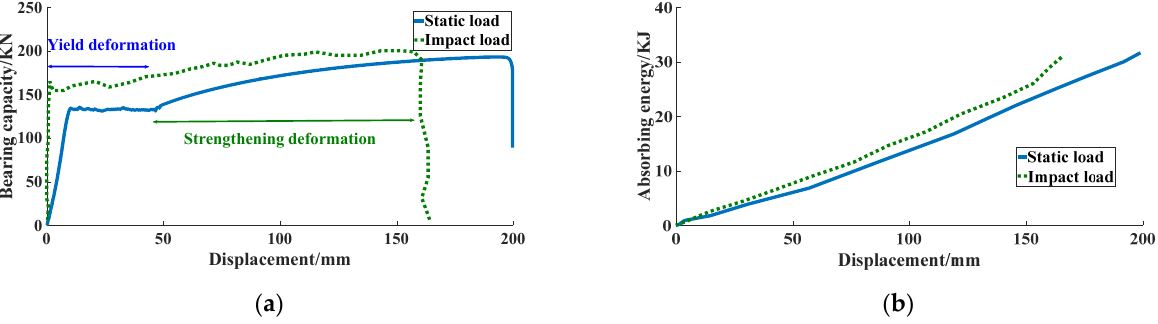
Figure 10. Mechanical property curves of conventional anchor rods ( a ) bearing capacity-displacement curve; ( b ) energy absorption characteristic curve. Table 4. Comparison of mechanical properties of conventional anchor.